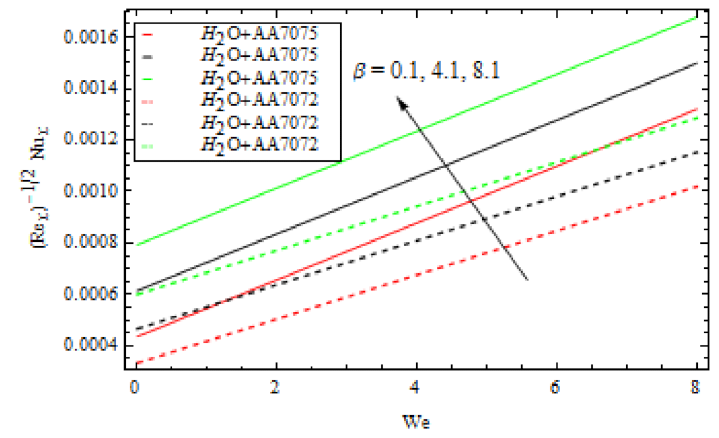
Figure 19. Various values of β versus We for nusselt number.